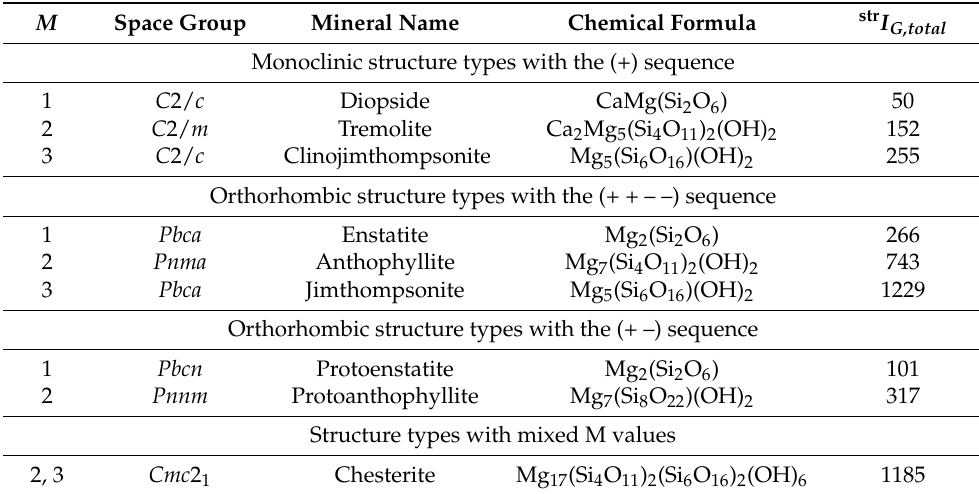
Table 2. Total structural complexities for basic biopyribole structure